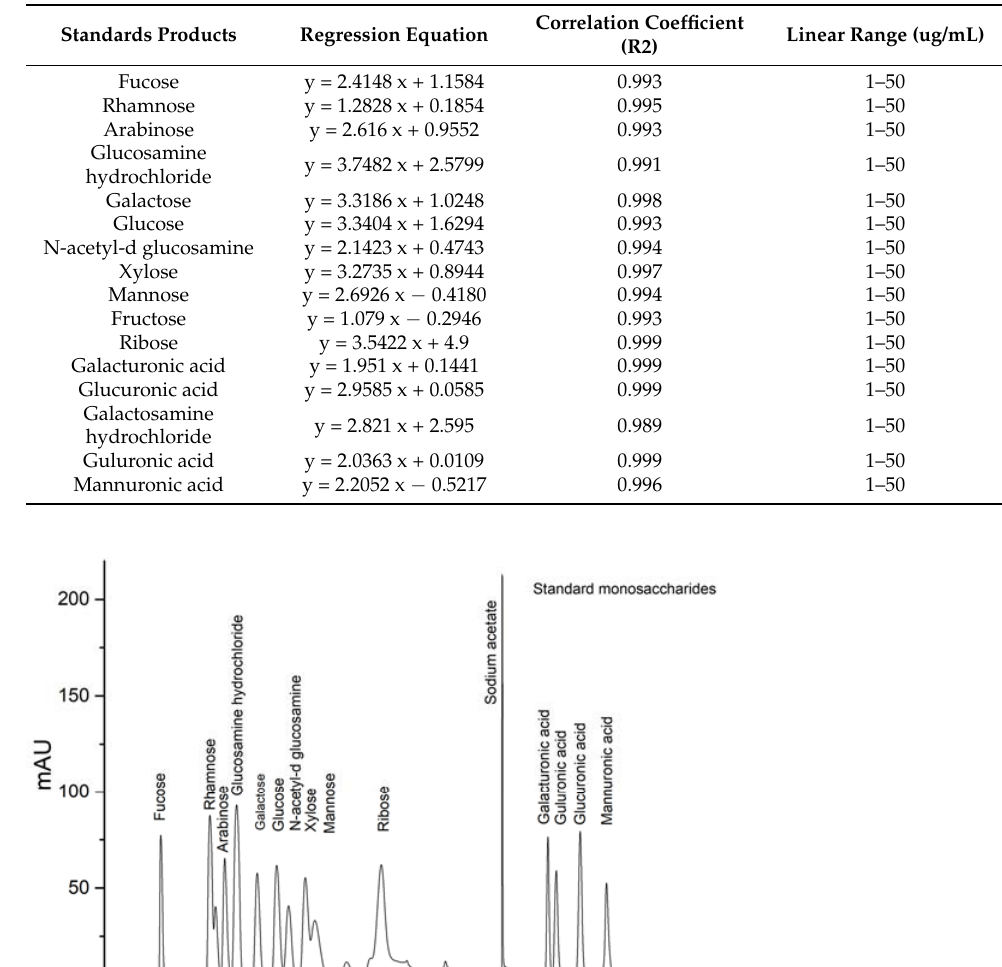
Table 1. Regression equations for 16 monosaccharide standards.